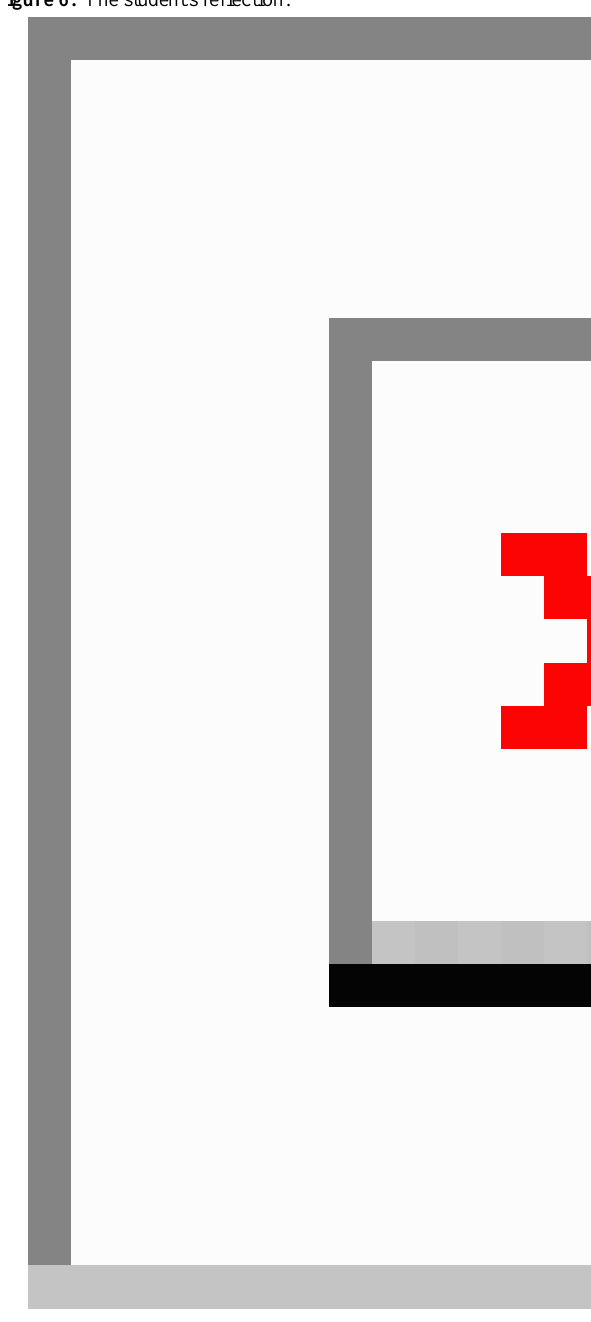
Figure 6. The student's